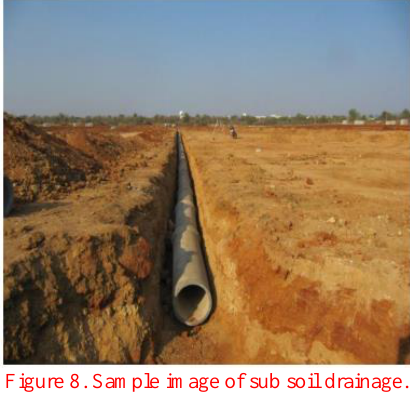
Figure 8. Sample image of sub soil drainage.